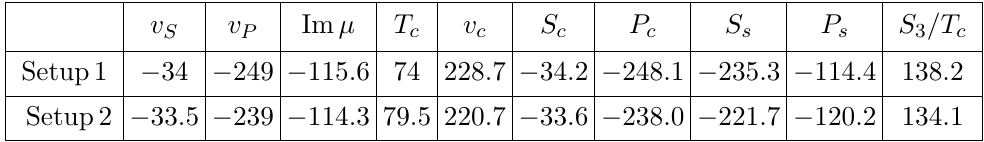
Table 2 . Parameters for the (cid:12)rst order EWPT in the split NMSSM (all quantities in GeV except dimensionless ratio S 3 =T c ).